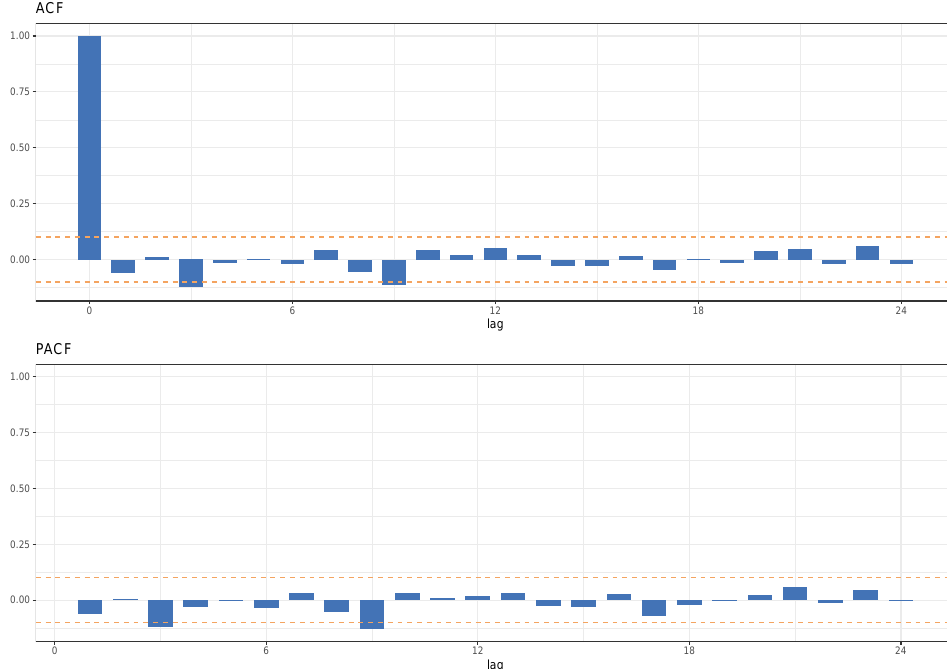
Figure 8. Estimated auto-correlations of the dataset Scored goals : ( top panel ) autocorrelation function (ACF); ( bottom panel ) partial autocorrelation function (PACF).